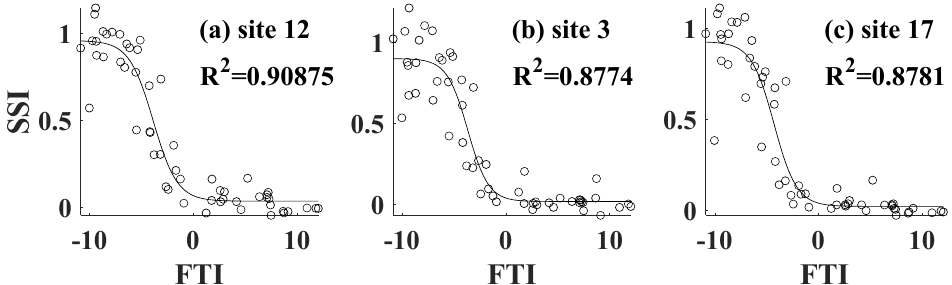
Figure 6. An example of scatters between SSI S1 and FTI from satellite data for cultivated land (( a ), site 12), grassland (( b ), site 3), and forest (( c ), site 17) over the Genhe watershed. Black circles represent the satellite data.